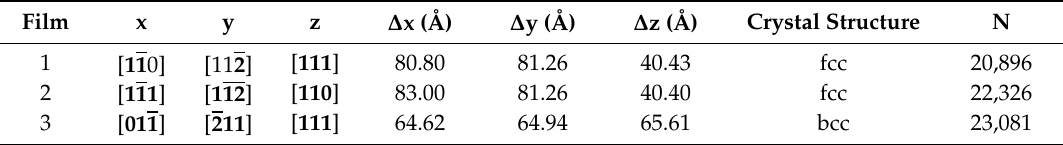
Table 1. Detailed information of the simulated thin films. The coordinate directions are indicated by x, y and z (surface normal). ∆ x, ∆ y and ∆ z are the thicknesses in each direction. N denotes the total number of